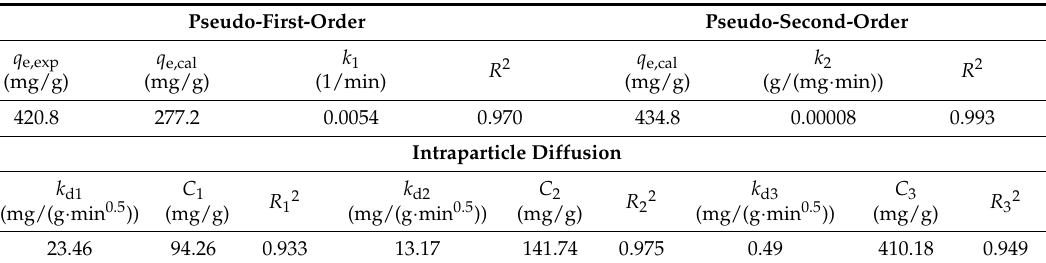
Table 2. Kinetic fitting results of Hg 2+ onto CoFe 2 O 4 @SiO 2